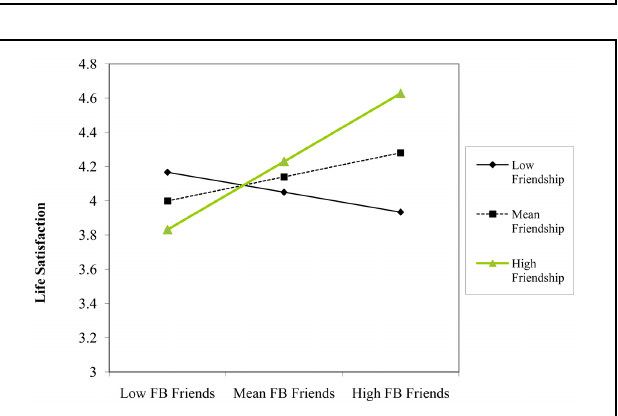
FIGURE 3 | Participant’s Facebook time and friendship level as interactive predictors of scores on loss of behavioral/ emotional control construct.